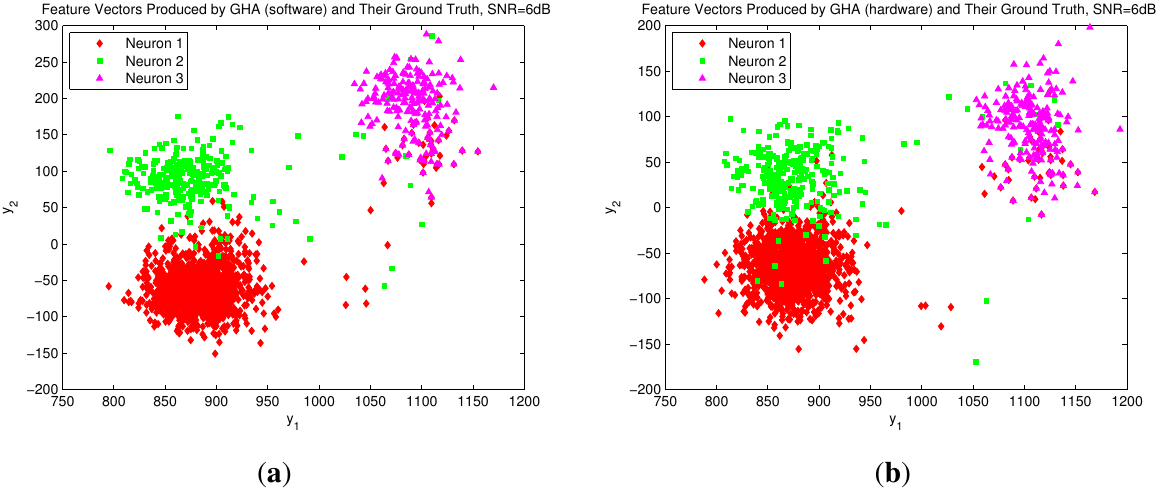
Figure 11. The distribution of the feature vectors extracted by GHA hardware/software implementations for spike trains generated by three neurons with SNR = 6 dB: ( a ) feature vectors produced by the GHA software; ( b ) feature vectors produced by the GHA